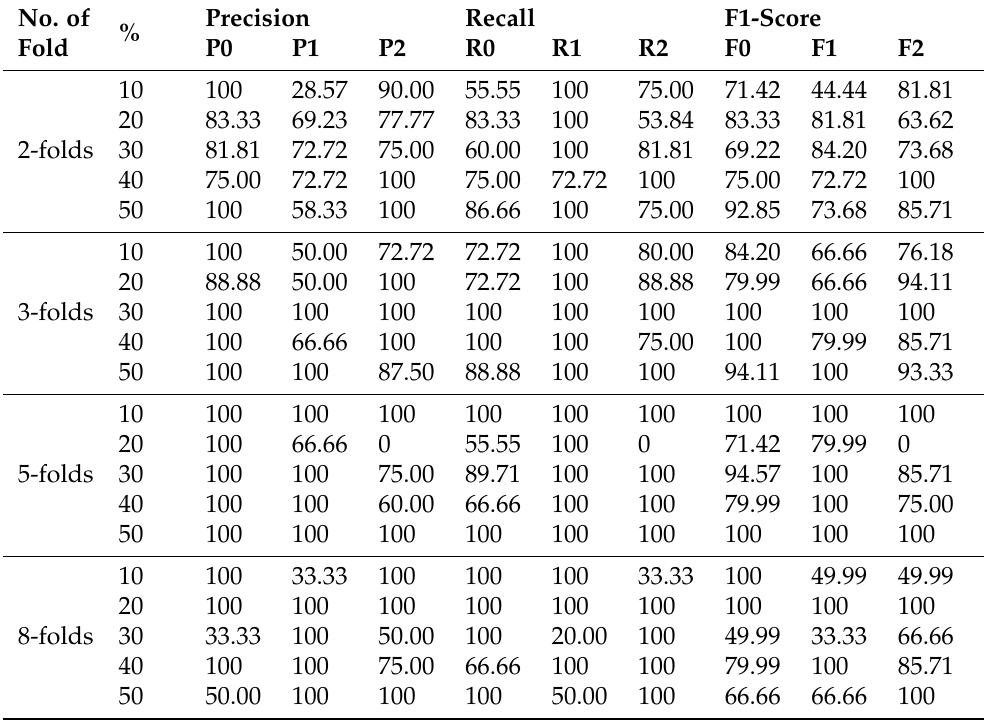
Table 3. Reference frame with